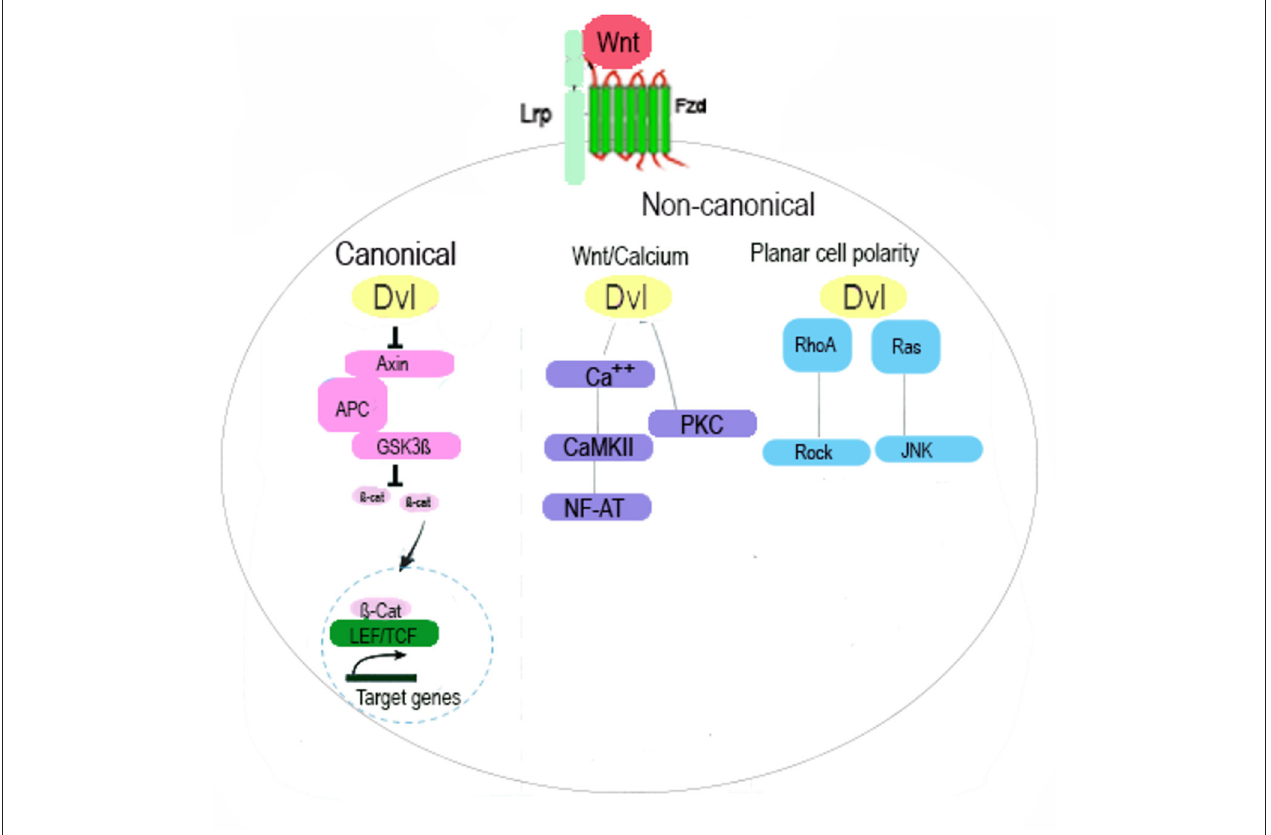
FIGURE 1 | Schematic Illustration of Wnt Signalling Pathway. The canonical Wnt pathway, acts through Fzd and LRP5/6 receptors is mediated by β -catenin and its translocation to nucleus, activation of TCF/LEF transcription factor and regulation of gene expression. Non-canonical Wnt pathway signals through Fzd and/or ROR1/ROR2/RYK receptors and is transduced by the WNT/PCP (planar cell polarity), WNT/RTK (receptor tyrosine kinase) and WNT/Ca 2 + signalling cascades. In the Wnt/Ca 2 + pathway, binding of Wnt to Fzd activates DVL which then activates calcium-binding proteins including protein kinase C (PKC) and calmodulin-dependent kinase II (CamKII) and subsequently transcription factor NFAT. In the Wnt/PCP pathway, signal is mediated by GTPases RhoA and Ras and activates RhoA-Rho-associated kinase (ROCK) axis or JNK and subsequently regulation the